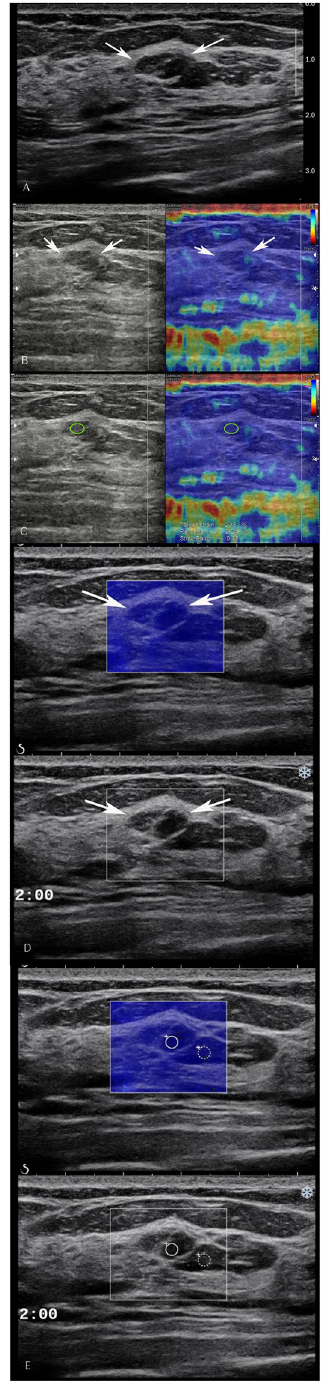
Figure 3. An abnormality detected via screening mammography in a 51-year-old woman. ( A ) Grayscale ultrasound shows an indistinct oval heterogeneous echoic mass (arrows) in the 2 o’clock area of the left breast which was categorized as a category 4a tumour with low suspicion of malignancy. ( B ) By strain elastography, the mass was graded with a visual score of 1 according to the Tsukuba system (arrows). ( C ) Strain ratio was 0.9. ( D ) By shear wave elastography, the mass was graded with a visual score of 1. ( E ) Elasticity ratio was 1.4. Ultrasound core biopsy confirmed the tumour to be a